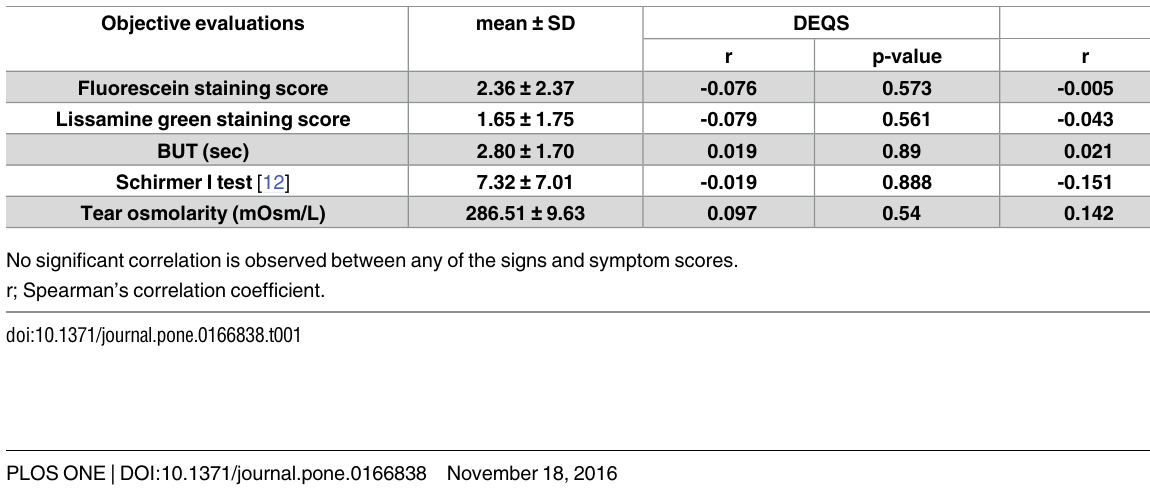
Table 1. Objective signs and symptom scores (DEQS and